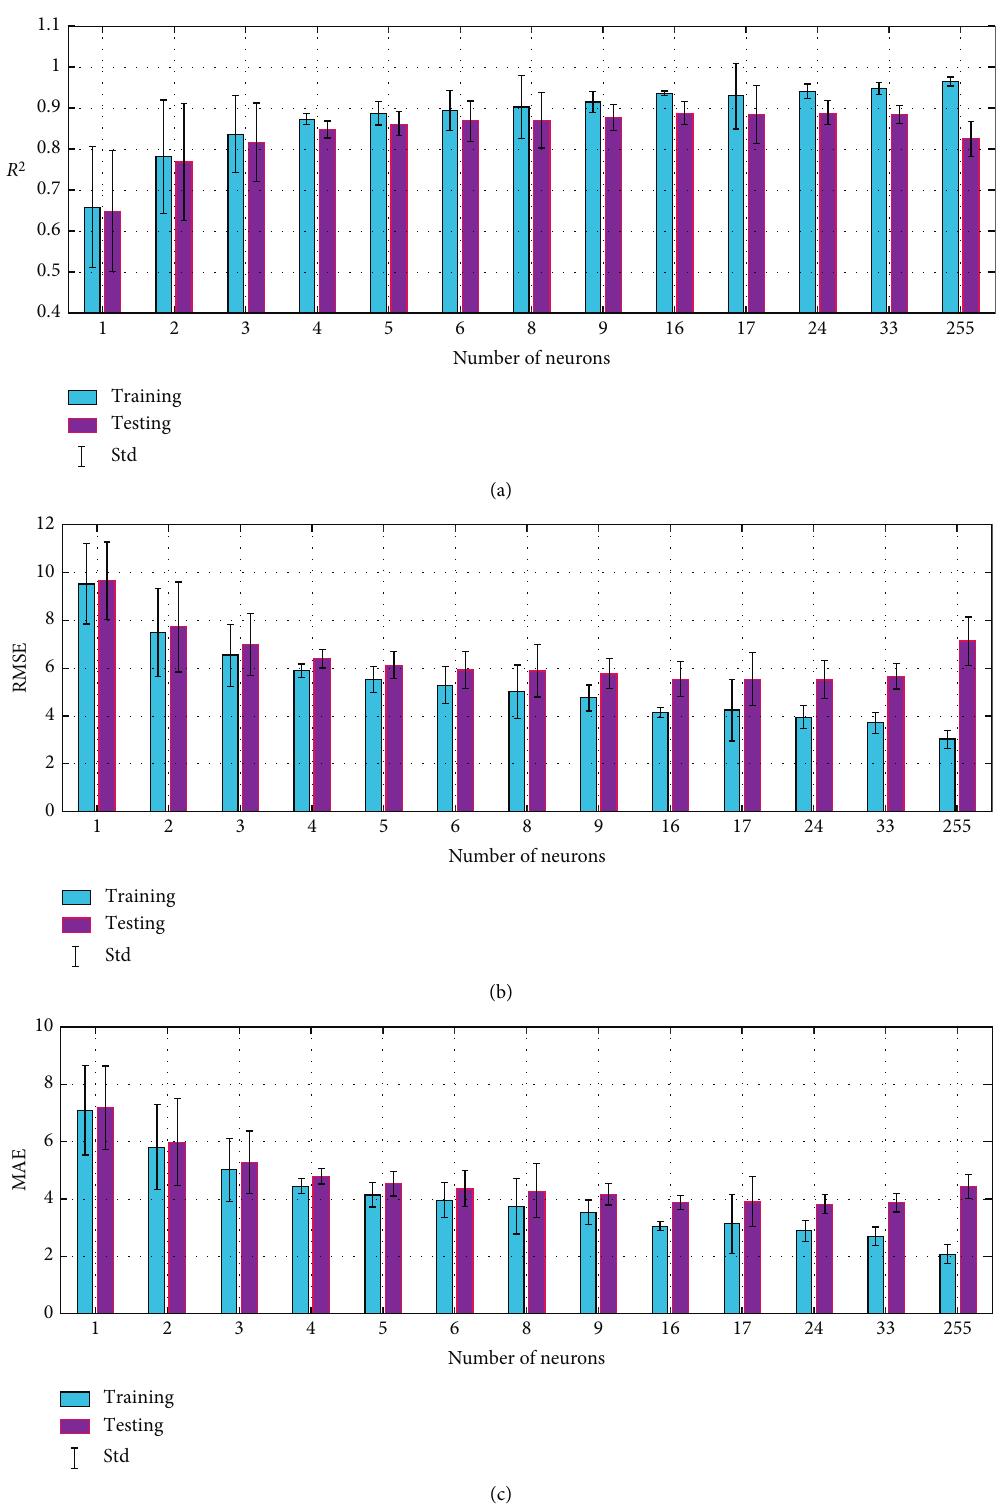
Figure 6: Analysis of the results over 100 simulations using different ANN structures: mean value and Std of (a) R 2 , (b) RMSE, and (c) 0.0295 for ANN-24N; and 0.885 and 0.0221 for ANN-33N, models corresponding to 16, 24, and 33 neurons, respec- respectively. For the RMSE criterion, the mean and Std tively. According to the testing part results, the mean and Std values are, respectively, equal to 5.5521 and 0.7268 for ANN- of R 2 are equal to 0.8886 and 0.028 for ANN-16N; 0.8895 and